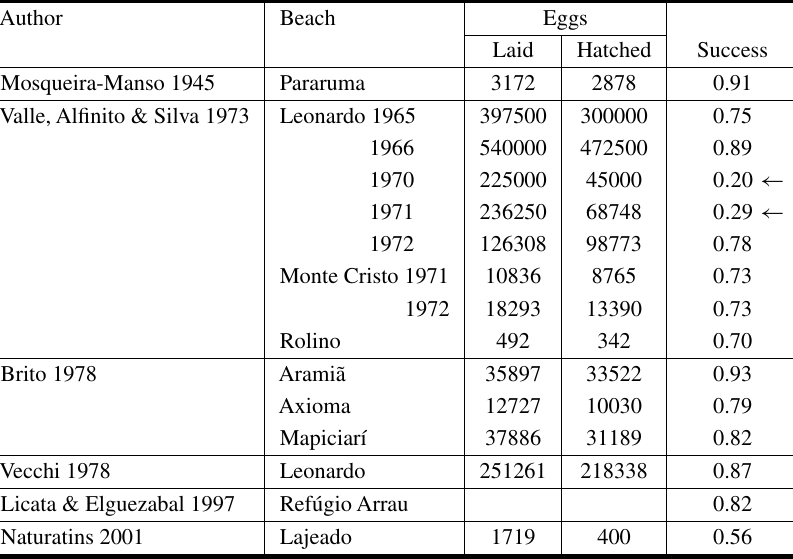
Podocnemis expansa , data on hatching success.